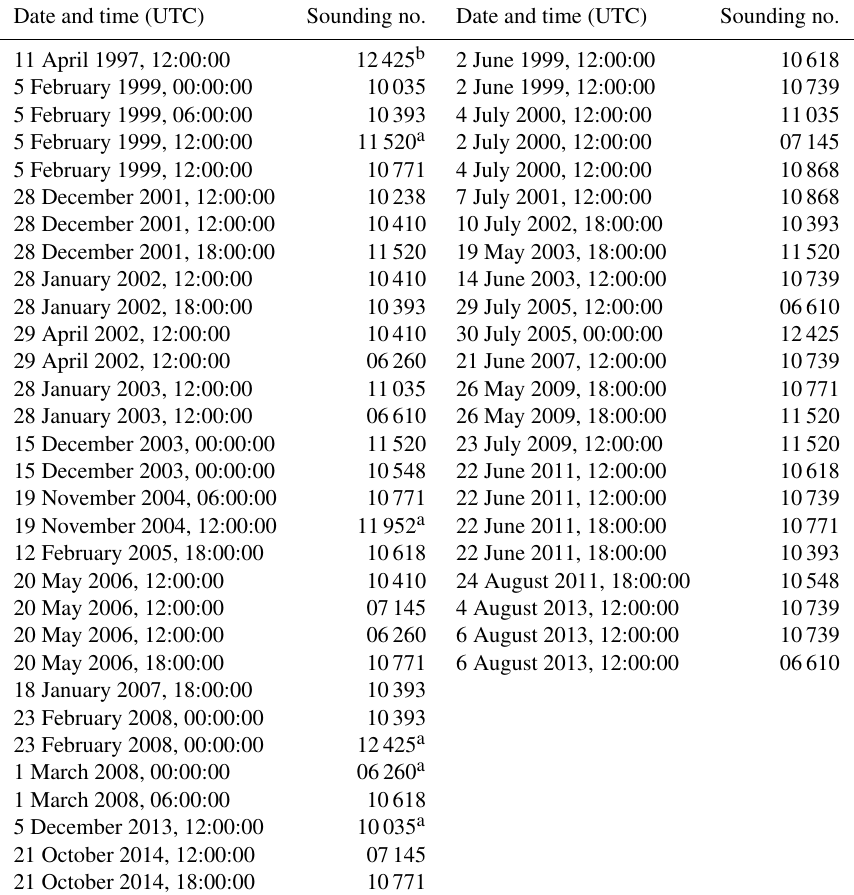
Table 2. Proximity soundings of derechos between 1997 and 2014. The left column lists soundings of cold-season-type derechos, and the right column lists soundings of warm-season-type derechos. Sounding sites are given by their WMO station identifier code. Soundings marked with a are chosen despite the fact that the derecho moved across the sounding site 3h after the sounding launch instead of 2h. For the sounding marked with b , there was no clear evidence that it was crossed by the derecho before or after the launch time.